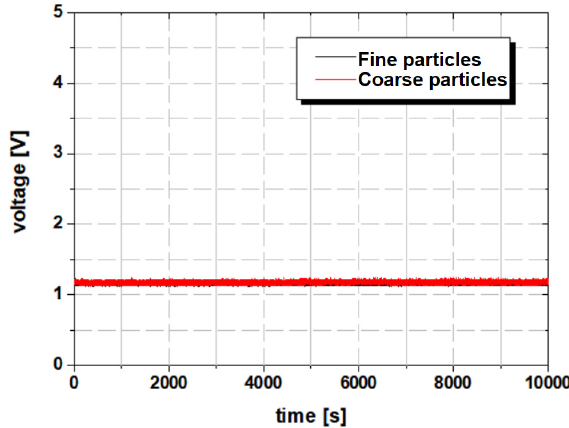
Figure 12 . Measured voltage with time in the second case. Figure 12. Measured voltage with time in the second